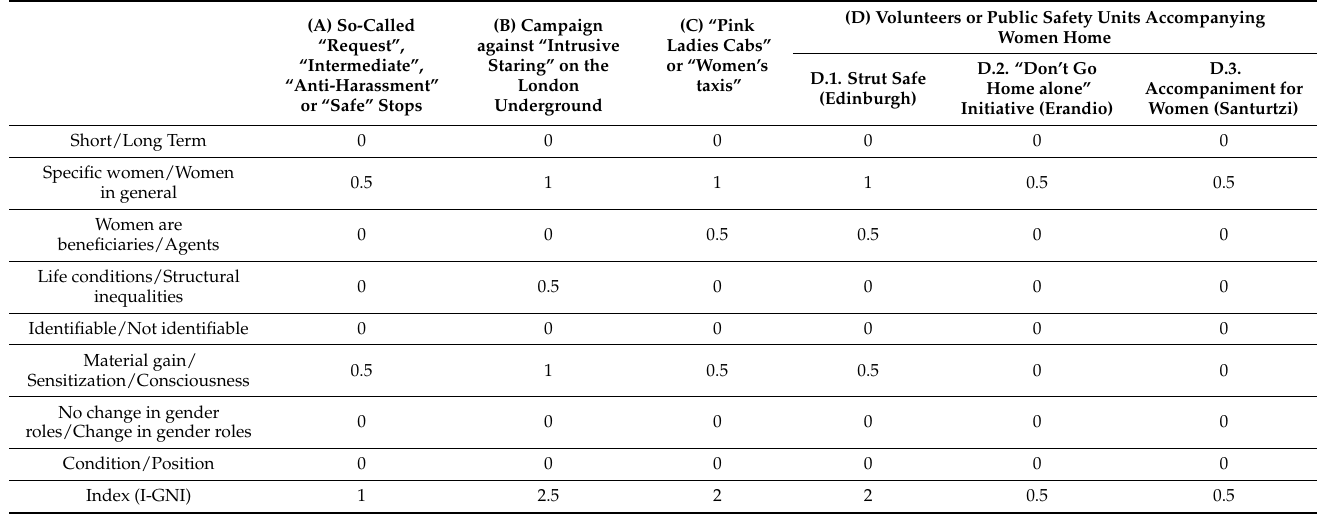
Table 8. Analysis of institutional initiatives against sexual violence in public space, according to the categorization of practical gender needs/strategic gender